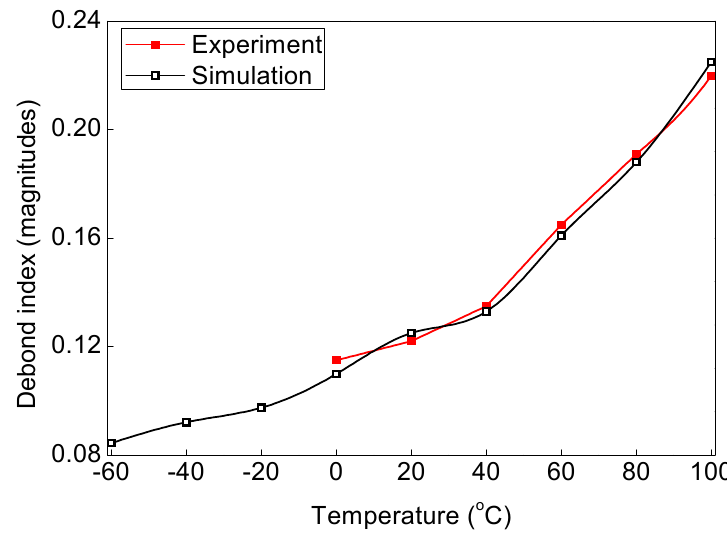
Figure 15. Change in debond index with the variation in ambient temperature.